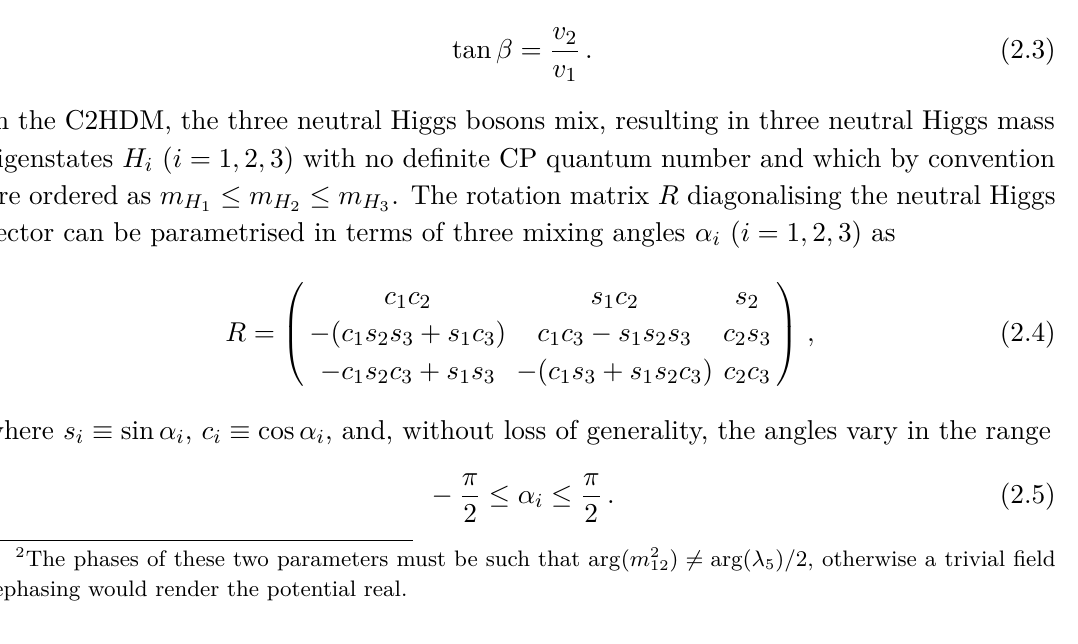
, the down-type quark singlet d R R